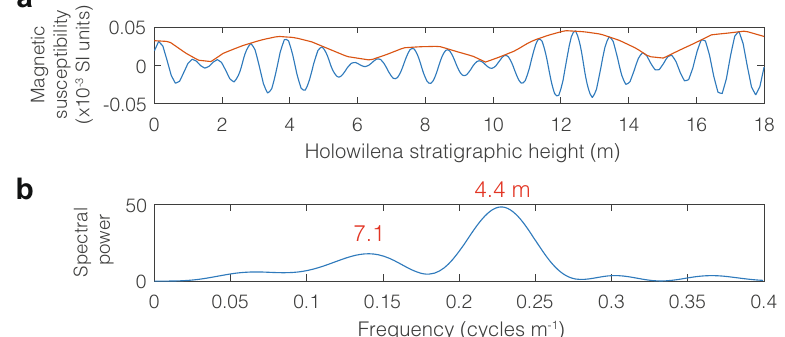
Fig. 4 Hilbert transform of putative precession signal in order to extract putative eccentricity signal. a Hilbert transform (red) extracted from precession bandpass fi lter (blue; Fig. 3b). b Fast-Fourier transform (FFT) of the Hilbert transform, indicating power in the eccentricity band (compare to Fig. 3a), as